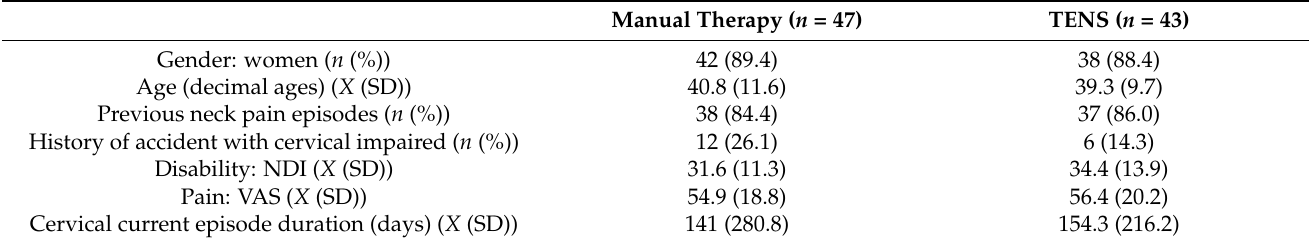
Table 2. Sociodemographic characteristics and the prognostic variables at